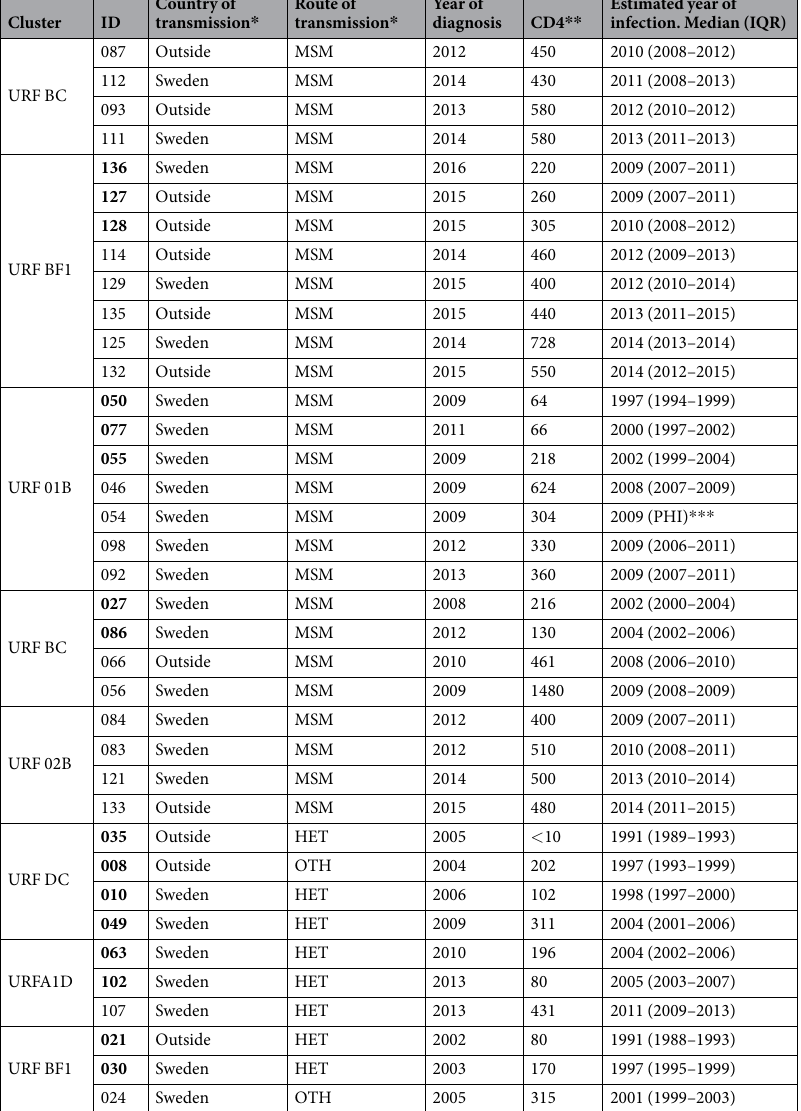
Table 2. Characteristics of eight transmission clusters with more than two patients, based on the pol gene using the FJ-method. Transmission clusters were constructed at 0.02-subs/site thresholds. * Reported by the treating physician; ** cells/ μ l at HIV-1 diagnosis; *** PHI: primary HIV infection; MSM: men who have sex with men; Hetero: heterosexually infected; OTH: other mode of transmission or unknown; Late presenters are marked in